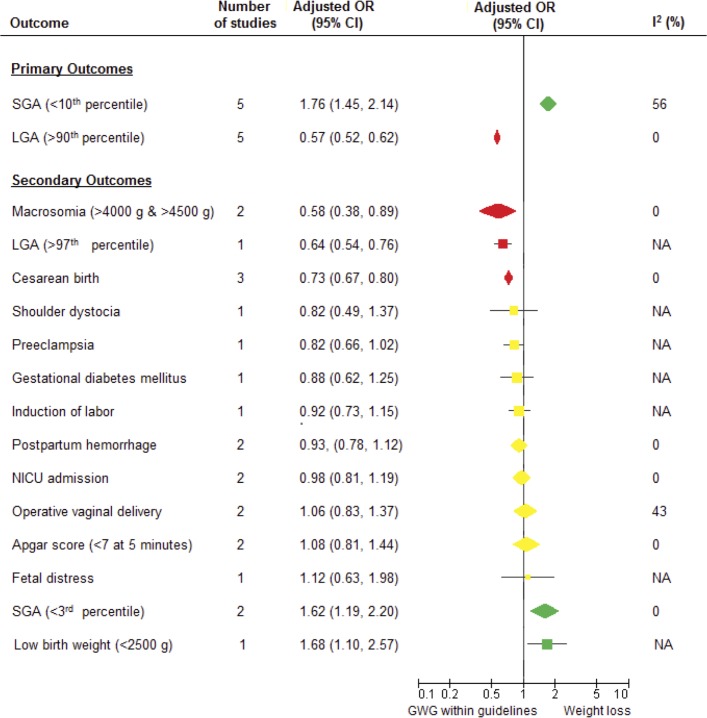
Summary of multivariable pooled odds ratios (95% confidence intervals) for the association between gestational weight loss and adverse pregnancy outcomes in obese women, compared to gestational weight gain within the 2009 Institute of Medicine guideline.